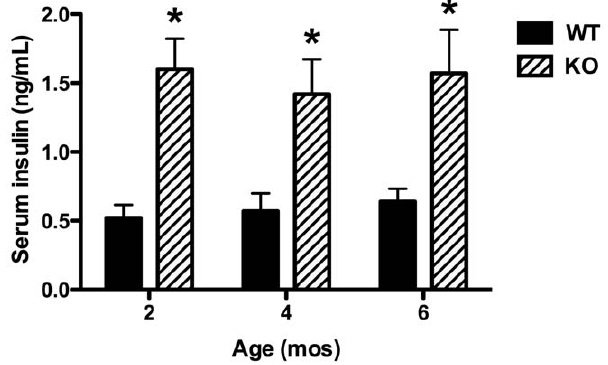
Figure 1. Constitutive hyperinsulinemia in IDE-KO mice. Insulin levels in serum of 2-, 4- and 6-mo-old wild-type (WT) and IDE-KO (KO) mice following overnight fasting. Data are mean 6 SEM of 10–12 mice per group. *P , 0.05 determined by 2-tailed Student’s t test.